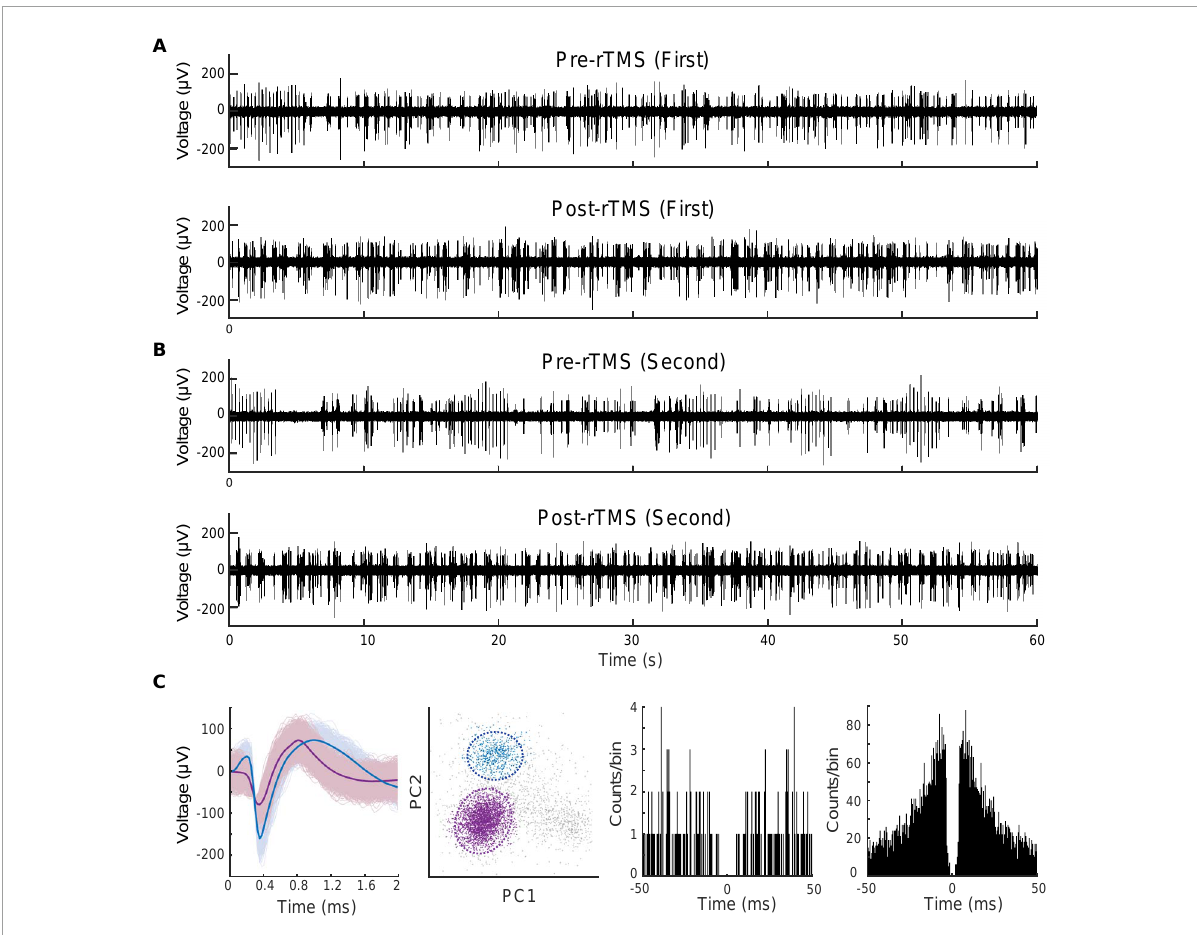
FIGURE10 Spontaneous unitary activities recorded pre- and post-rTMS. One-minute of high pass filtered (250 Hz) signals from the M1 before and after the first (A) and second (B) course of rTMS. (C) Waveforms, PCA clusters, and spike autocorrelograms ( ± 50 ms, bin size: 0.5 ms) of two units sorted from this